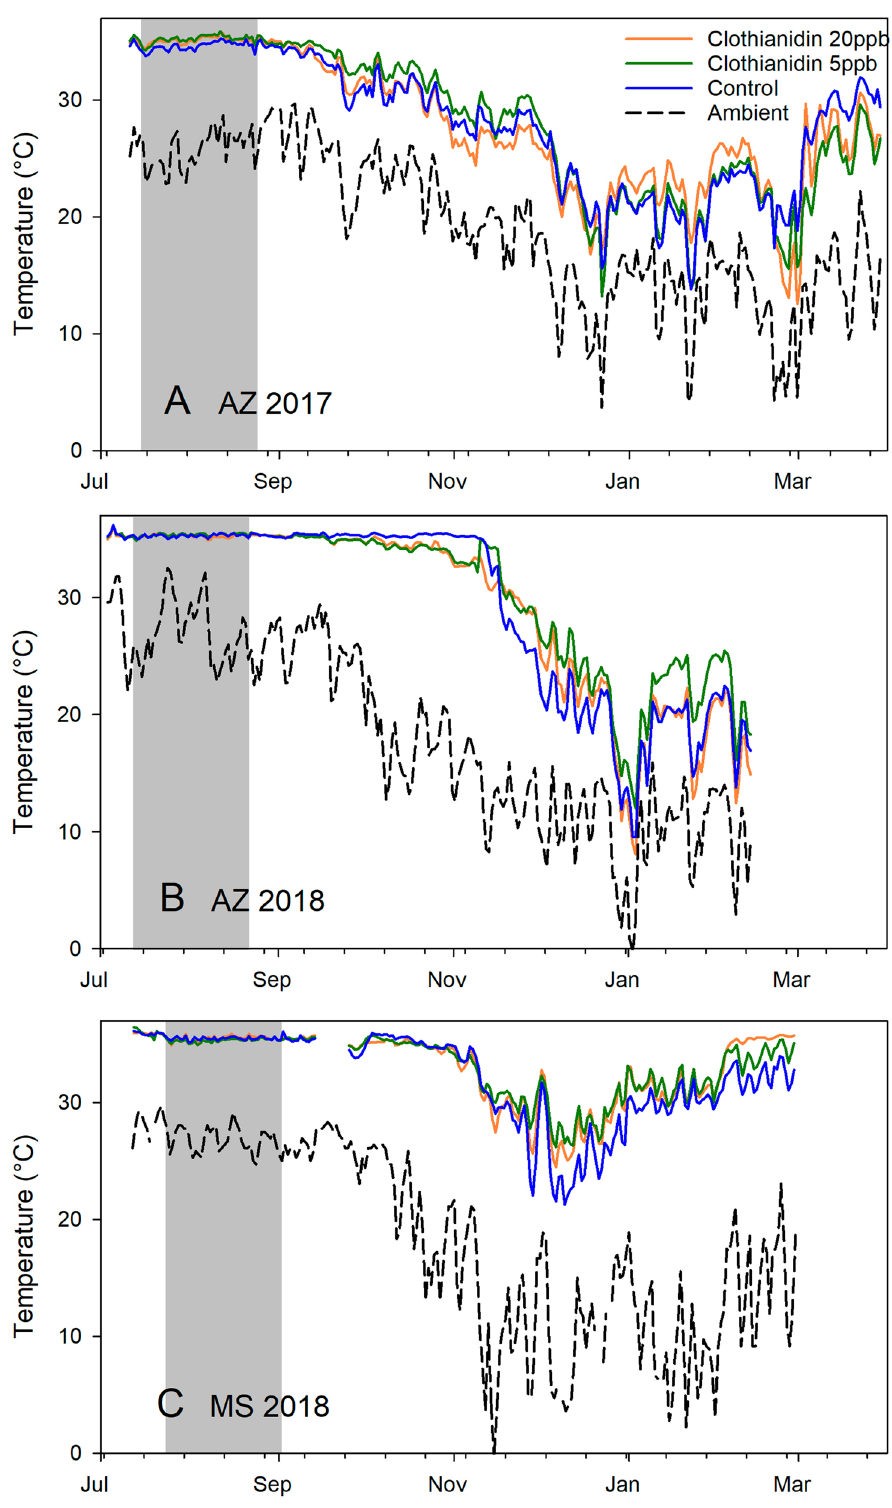
Figure 6. 24 h running average internal hive temperature (°C) per hour for each of 3 treatment groups: Clothianidin 20-ppb (orange), clothianidin 5-ppb (green), control (blue) compared to ambient temperatures (black) across 3 experiments. The gray area shows the treatment period. ( A ) AZ 2017; ( B ) AZ 2018; ( C ) MS